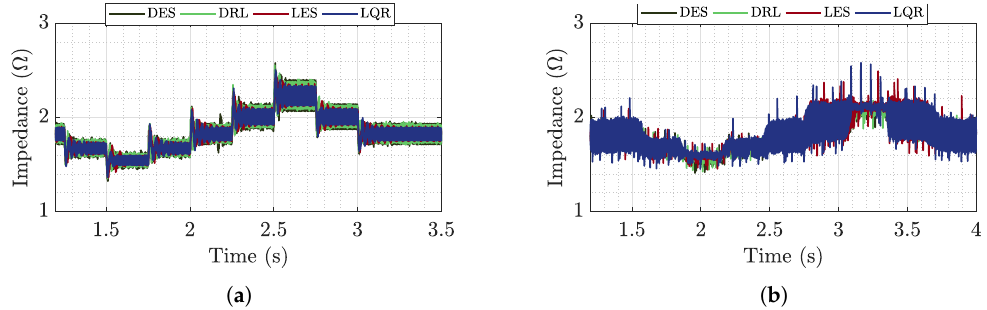
Figure 30. Impedance of the feeder buck in time during the ( a ) simulation and ( b ) test.